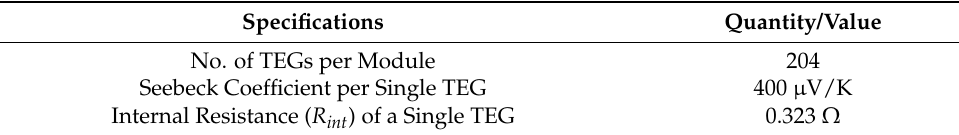
Figure 2. P-V curve of the proposed thermoelectric generator (SP1848) at various temperature differences. Table 1. Specifications of the proposed TEG module.